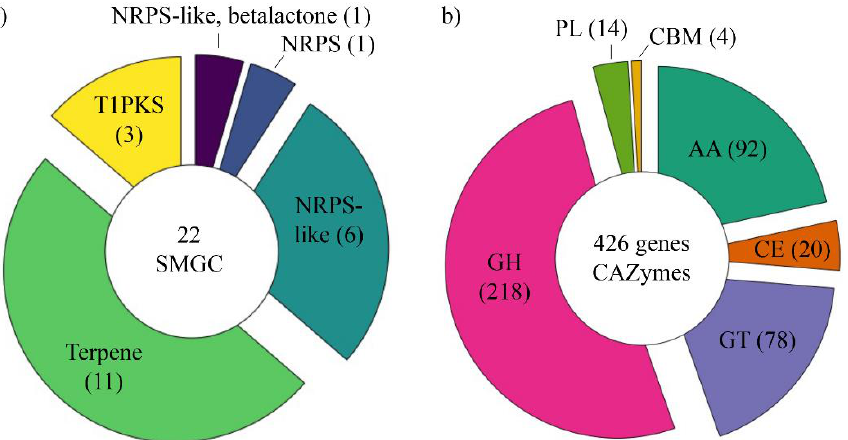
Figure 3. Annotation of Secondary metabolite gene clusters (SMGCs) and Carbohydrate-Active enzymes (CAZymes). ( a ) SMGCs identified in the genome of Trametes villosa CCMB561. ( b ) CAZymes identified in the genome of Trametes villosa CCMB561.